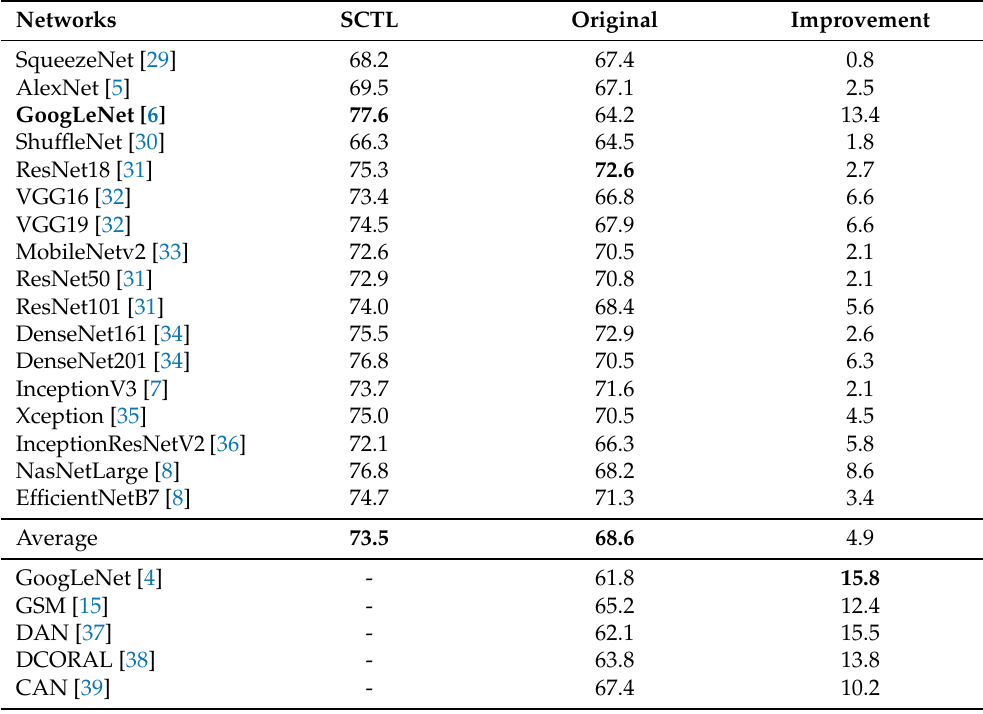
Table 2. Accuracy of different ImageNet models and the ablation study. GoogLeNet demonstrated the highest accuracy and greatest improvement when adopting